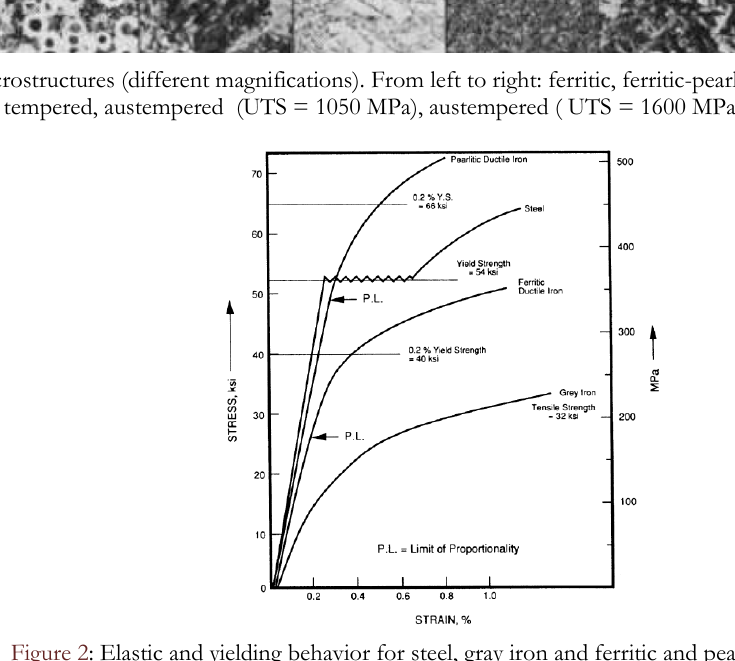
Figure 2: Elastic and yielding behavior for steel, gray iron and ferritic and pearlitic DCIs